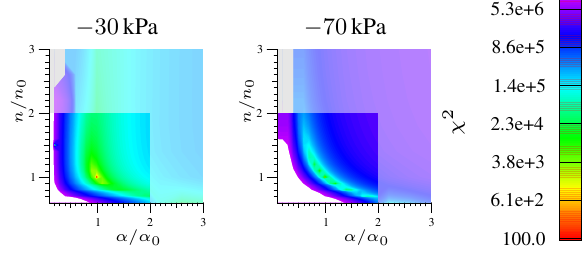
Fig. 14. Same as Fig. 12 but for different tensiometer tear-off values ψ limit with j w and ψ m as target variables.